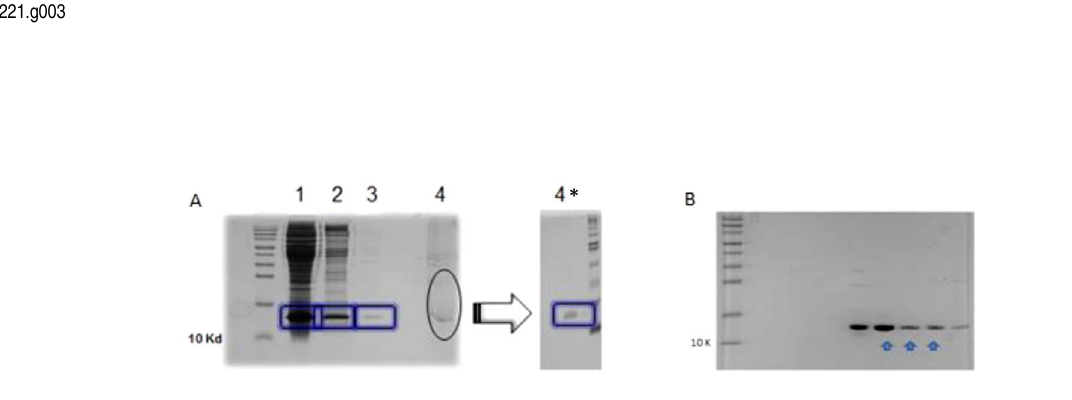
Figure 4. SDS-polyacrylamide gel electrophoresis (16%). A : supernatants 1, 2, 3, 4 obtained from steps 1- 4 following expression in BL21(DE3) cells. 15 m l of supernatant was run on 16% SDS-polyacrylamide gel, the asterisk indicates the solubilized pellet after 15x dilution with water to assist visualization. B : protease fractions after reversed-phase high performance liquid chromatography, arrows indicate the pooled fractions.